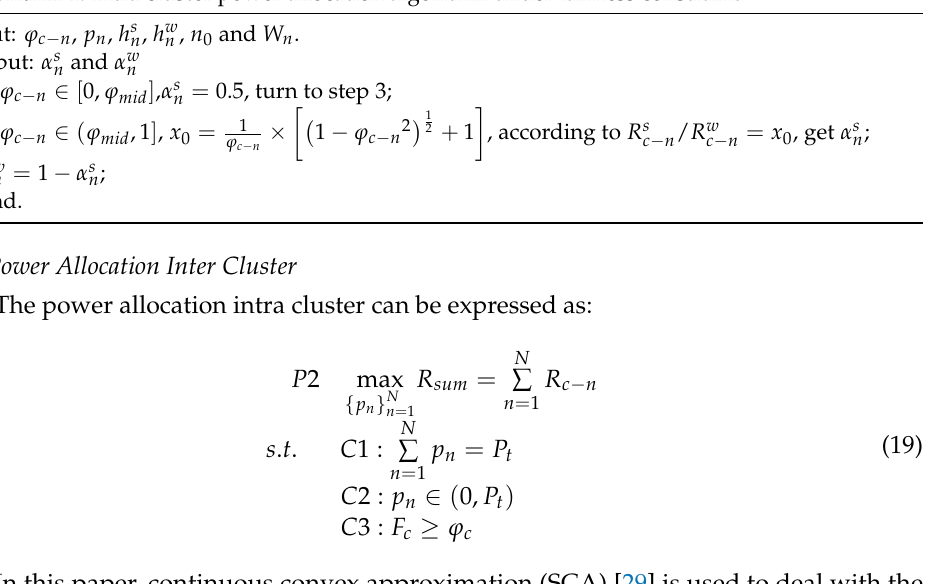
Algorithm 1: Intra cluster power allocation algorithm under fairness